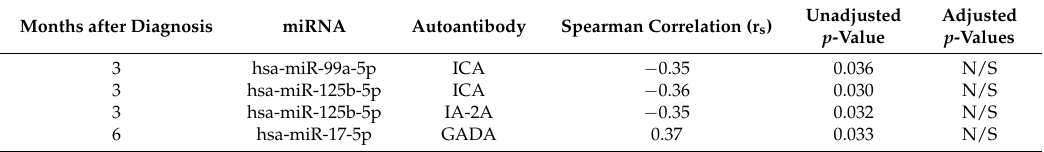
Table 4. Association between the eight candidate miRNAs and autoantibodies titers. Months after